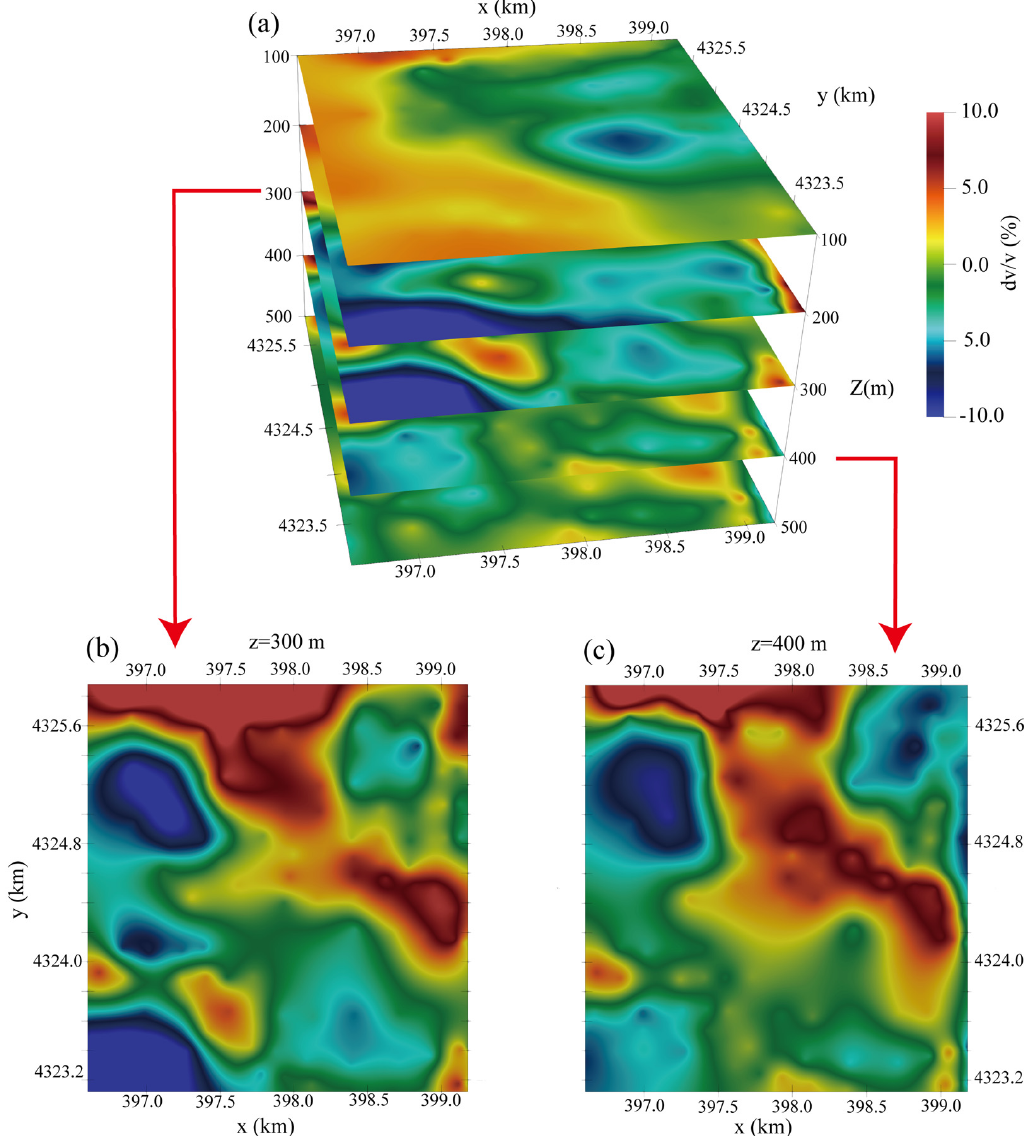
Figure 8. Plain view (relative perturbation) of the 3D S-wave velocity model. ( a ) Overview of the slices of ~ 100–5000 m; ( b ) slice at the depth of 300 m; and ( c ) slice at the depth of 400 m.